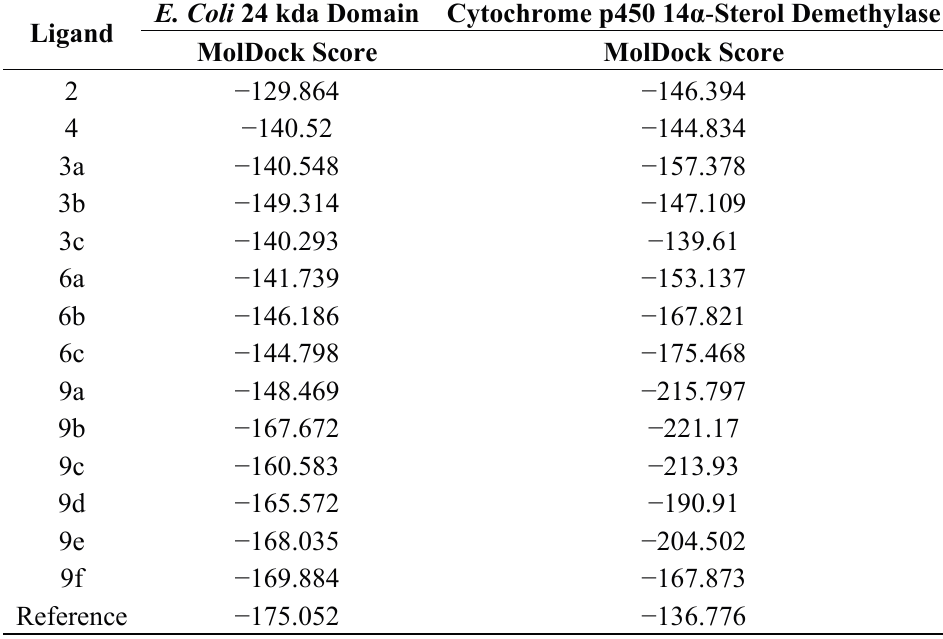
Table 5. MolDock scores for the reference and tested